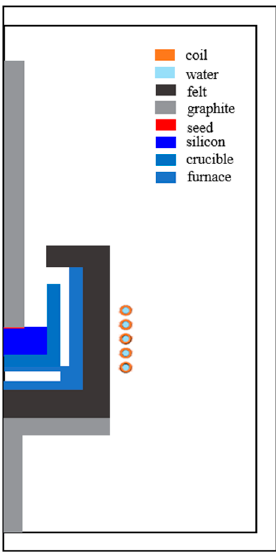
Figure 1. Simplified schematic of the computed area.